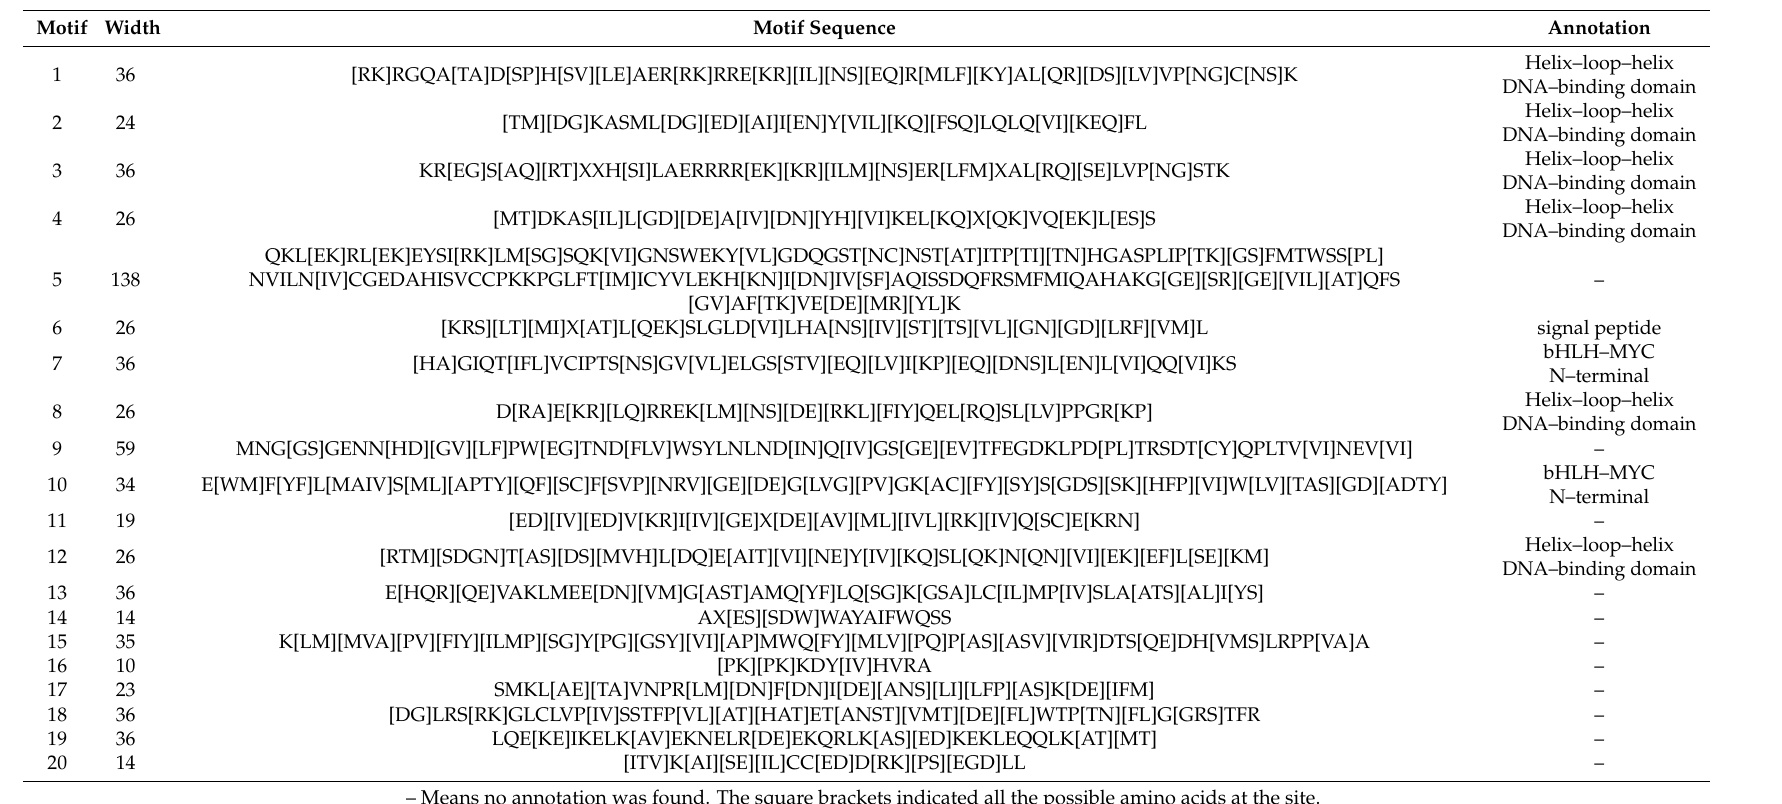
Table 1. Sequences of 20 predicted motifs of StbHLH